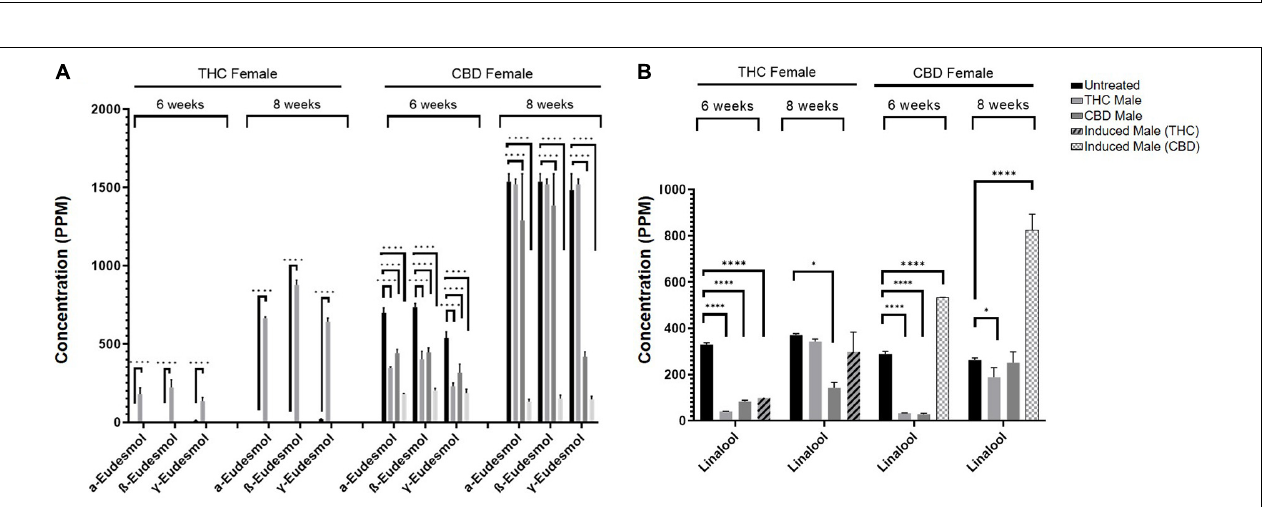
Frontiers in Plant Science |